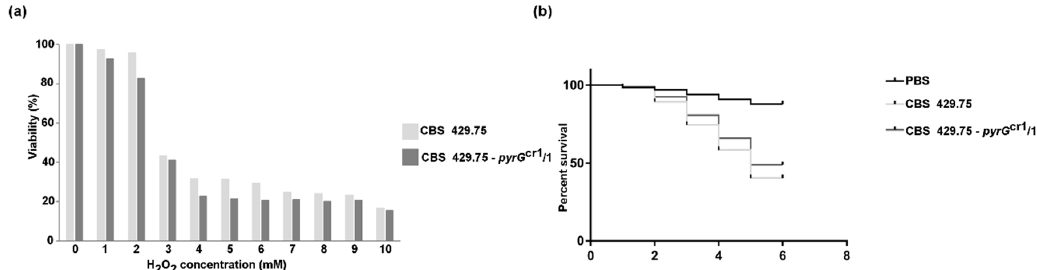
Figure 6. ( a ) Susceptibility of the original L. corymbifera strain (CBS 429.75) and one of the mutants (CBS 429.75– pyrG cr1 / 1) to H 2 O 2 . ( b ) Virulence of the strains CBS 429.75 and CBS 429.75– pyrG cr1 / 1 in Drosophila survival